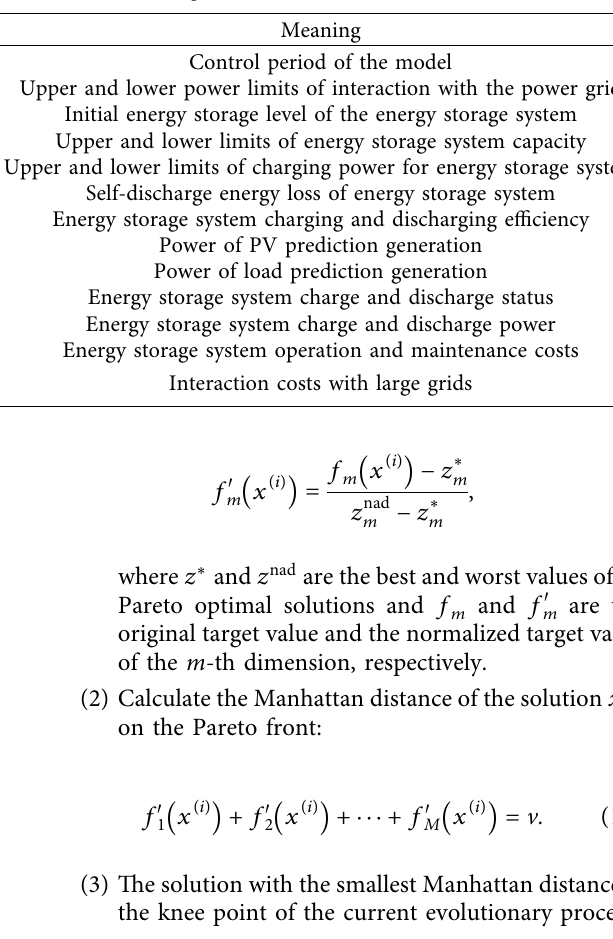
Table 1: Parameter name and